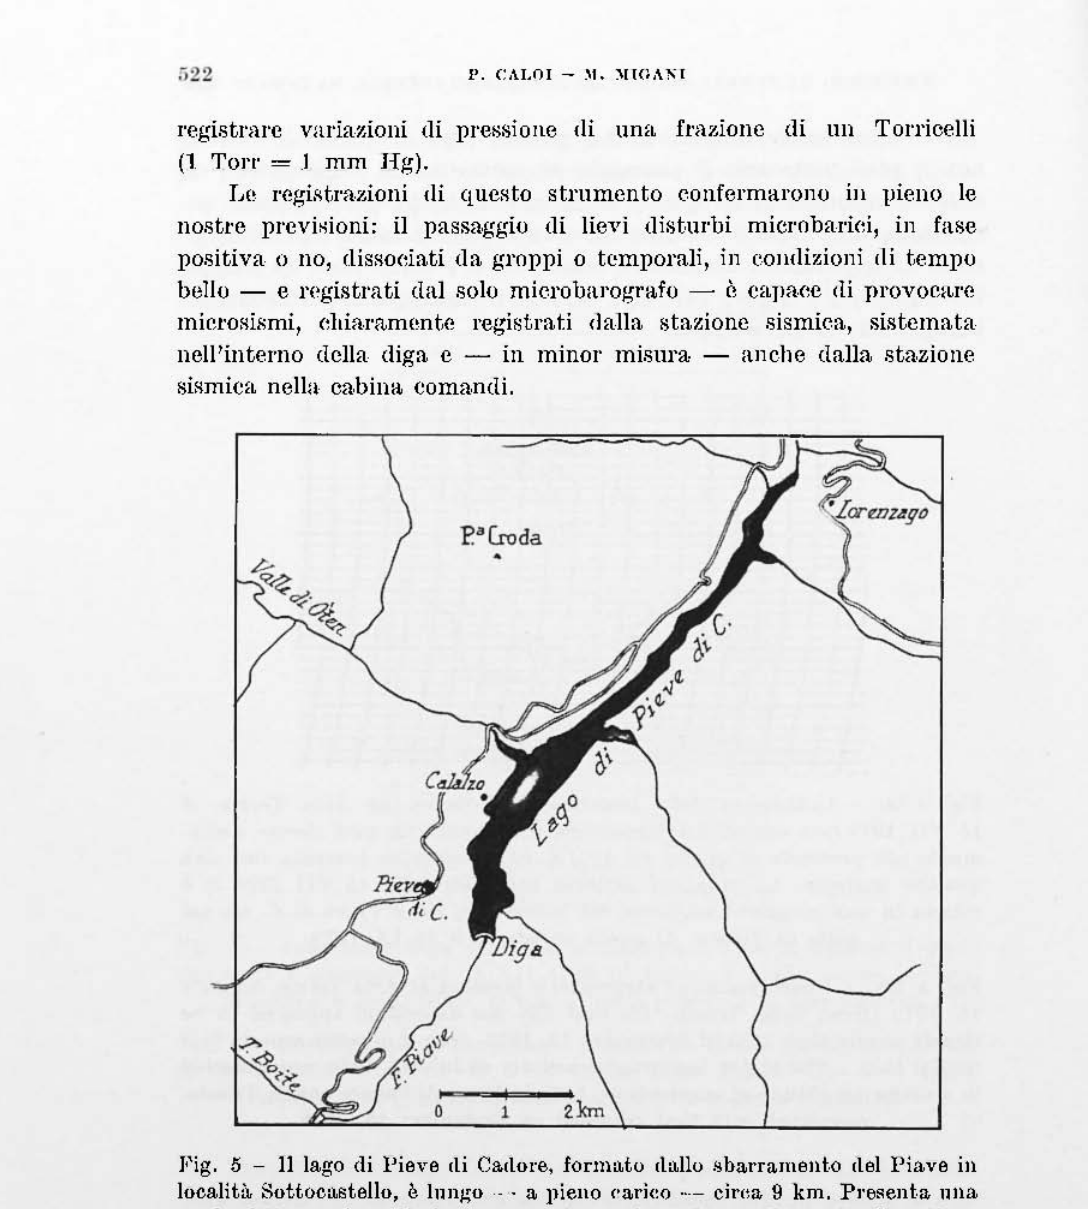
Fig. l'.i - 11 lago di Pieve (li Ca(lore, formato (lallo sbarrament.o (lei Piave in località Sottocastello, è lungo _. a pieno ('ari(~o .. _- cima 9 km. Pre~ent.a una profolUlità massima (li oil"1'a 100 m, in corrispon(lenza (li un piccolo settore ((luello (li destra) della diga; nel rimanenLe cont.atto con la diga, l'acqua raggiunge la profOlulità mw;.~ima (li 60 m ca. Fig. il - The Lake of Pieve di Cadore, formod by blocking the Piave at Hotto('astello, i8 about 9 km~ long when entirely fille(L 1ta maximum dept.h is atout 100 ms which corresponds to a small seetion (at the right) of the (Iam. 'l'he lake (lepth at the rest or the (lam is not over GO